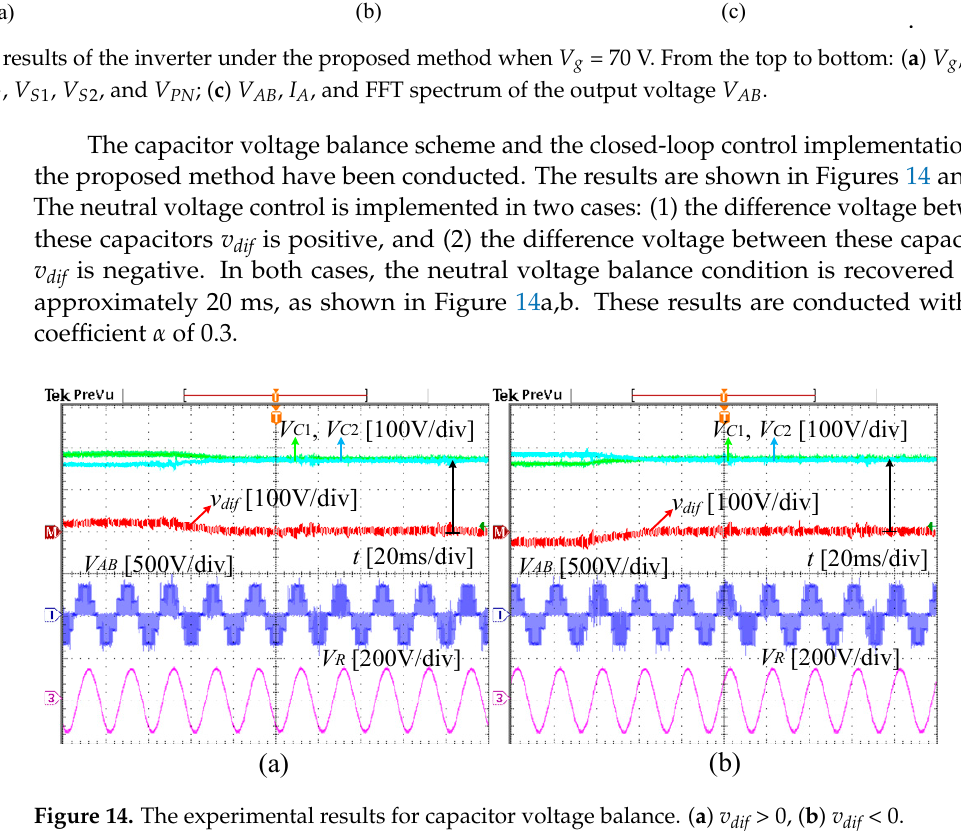
Figure 14. The experimental results for capacitor voltage balance. ( a ) v dif > 0, ( b ) v dif < 0.